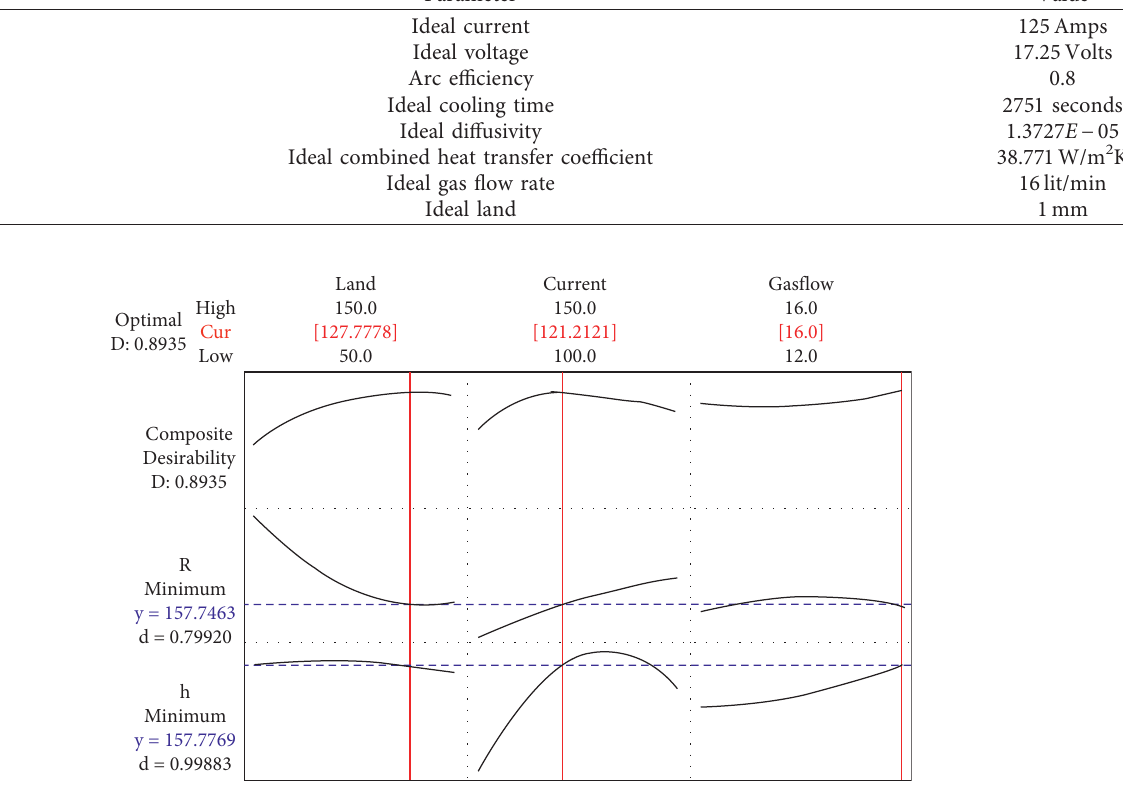
Figure 22: Optimal parameters—Taguchi analysis. Table 19: Structural results of dissimilar double V 45 ° .